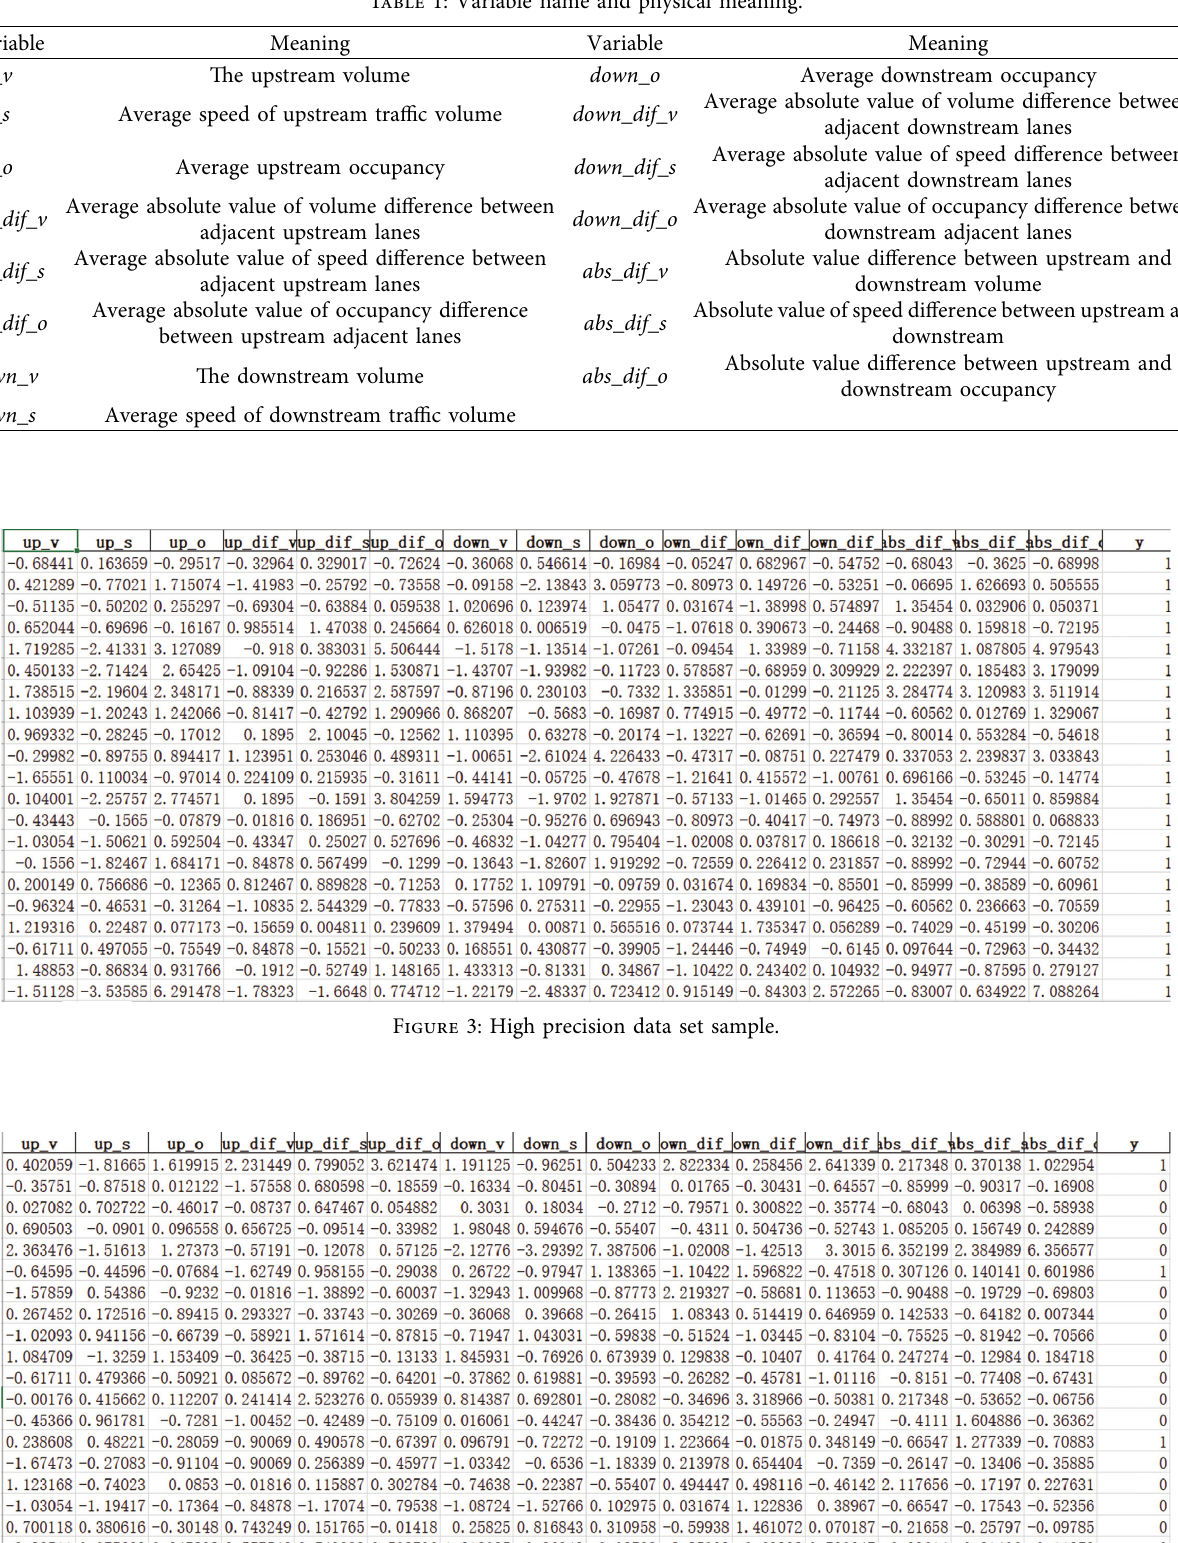
Table 1: Variable name and physical meaning.